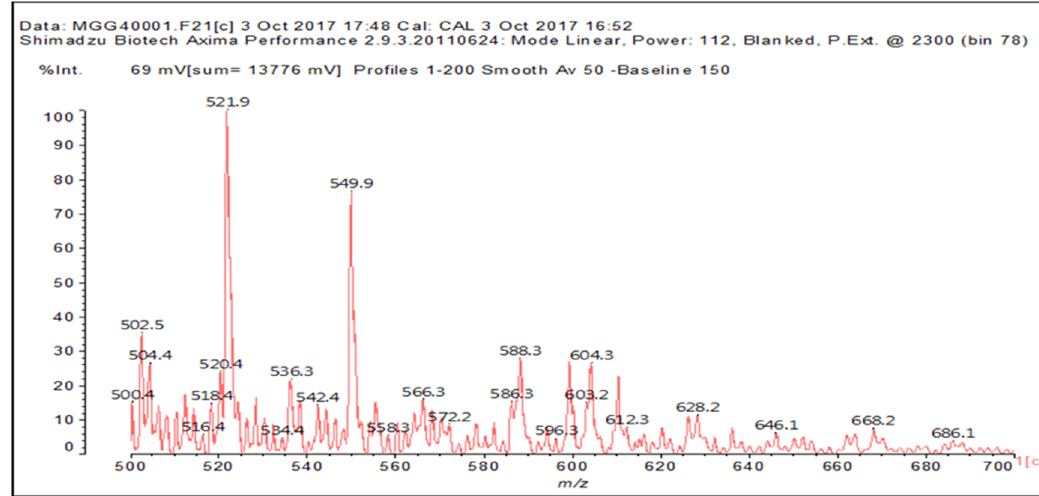
Figure 5. MALDI-ToF spectrum of the interaction between melamine and N -methyl-2-pyrrolydone hydrogen sulphate ([HNMP] [HSO 4 − ]) ionic liquid. 500–700 Da Table 5. Species formed by reaction of IL with melamine alone. Only two peaks could be interpreted. The rest are fragments either coming from impurities or fragments generated in the MALDI. It is clear that the melamine itself is not affected by the IL, although species like the 538 Da could facilitate reaction with the aldehydes. Peak